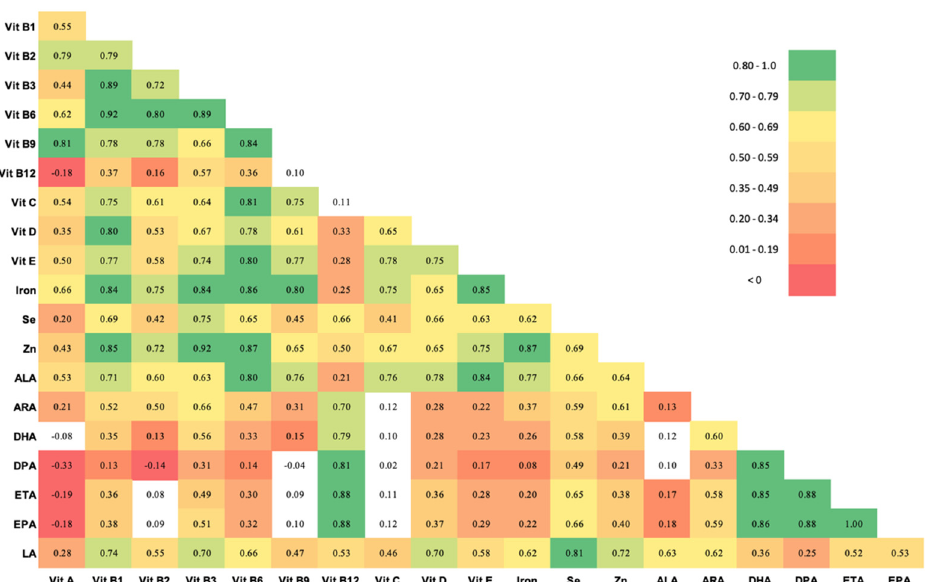
Figure 2. Spearman correlations between 20 nutrients in pregnant women in the Projahnmo cohort, Sylhet, Bangladesh. Unshaded cells did not meet statistical significance. Abbreviations: Vit = Vitamin, Se, selenium; Zn, Zinc; ALA, Alpha Linolenic acid; ARA, arachidonic acid; DHA, docosahexaenoic acid; DPA, docosapentaenoic acid; ETA, eicosatrienoic acid; EPA, eicosapentaenoic acid; LA, linoleic acid.